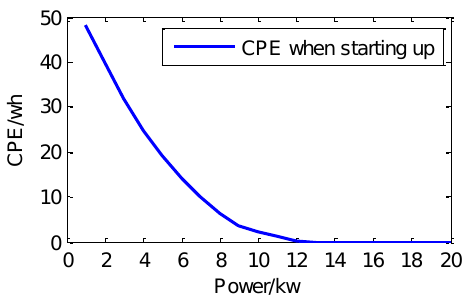
Figure 9. CPE results when starting up.